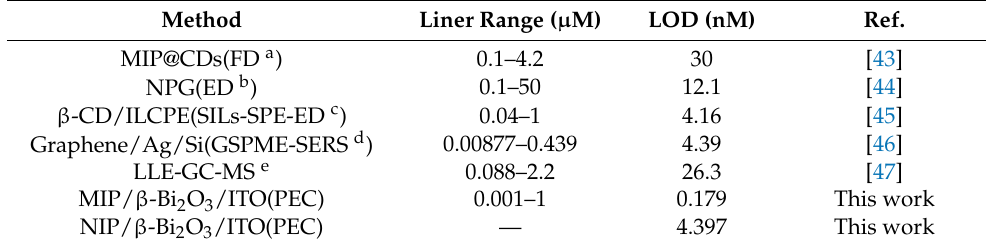
Table 1. Comparison of different BPA detection methods.